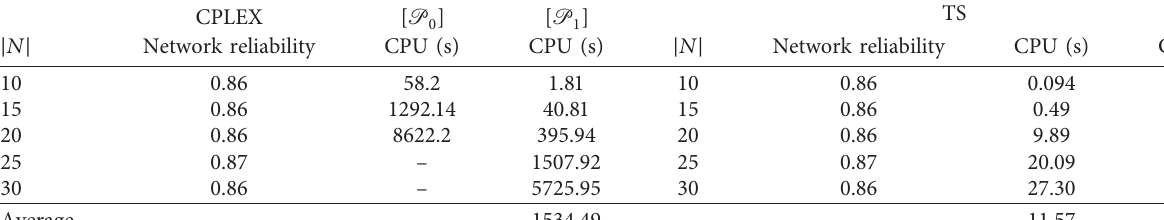
Table 5: Comparison results between CPLEX and TS for the Turkish network.